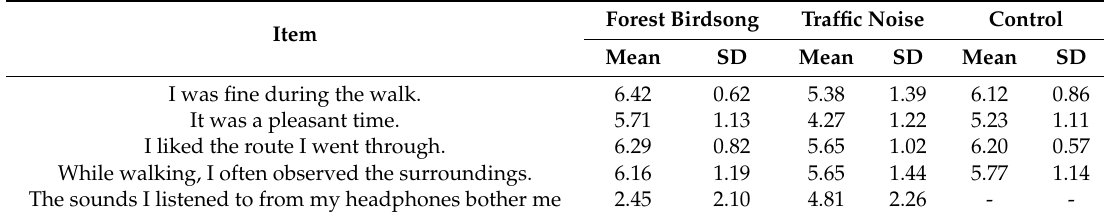
Table 3. Evaluation of the walk experience. The level of agreement with particular items. The scale ranged from 1 to 7. Forest Birdsong Traffic Noise Control Item Mean SD Mean SD Mean